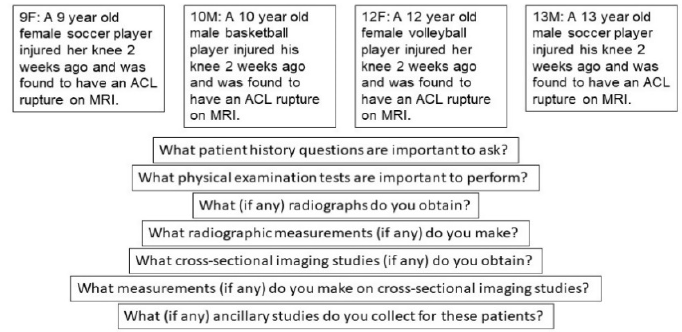
Figure 1. Case vignettes provided to panelists in Delphi study to evaluate management of pediat- ACL ric ACL injury.